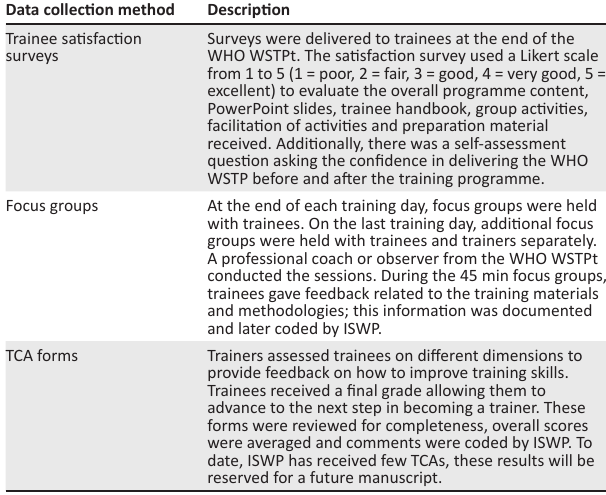
TABLE 1: Data collection